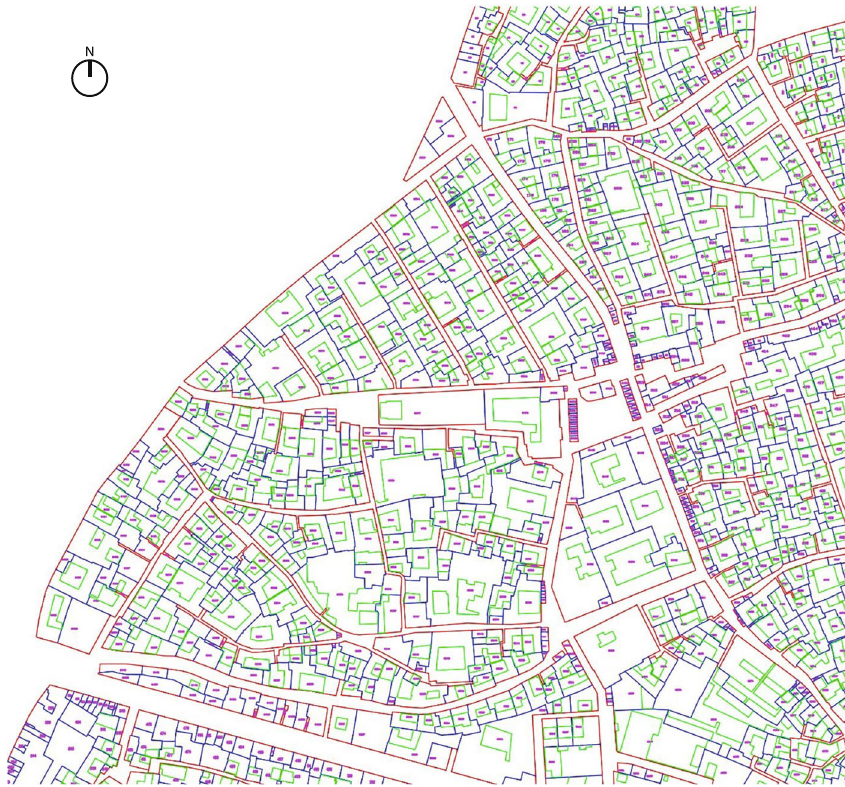
Fig. 4 The Al-Judayda Area from the Selection of Digitised 1927–1931 Maps of Aleppo (Source: GTZ and DOCA 2003)